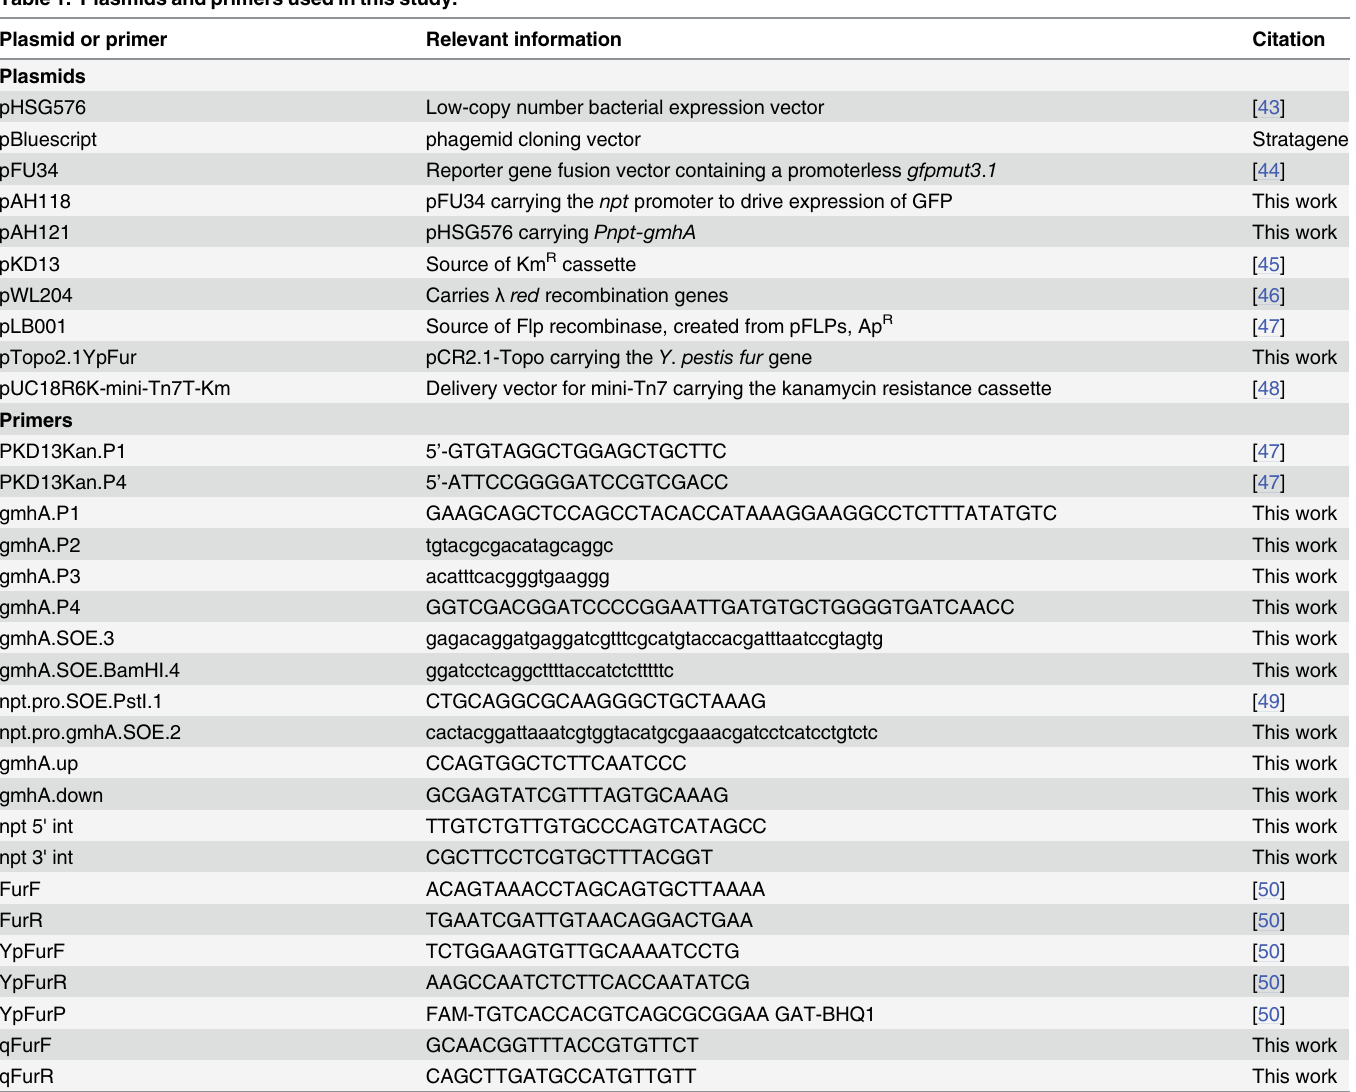
Table 1. Plasmids and primers used in this